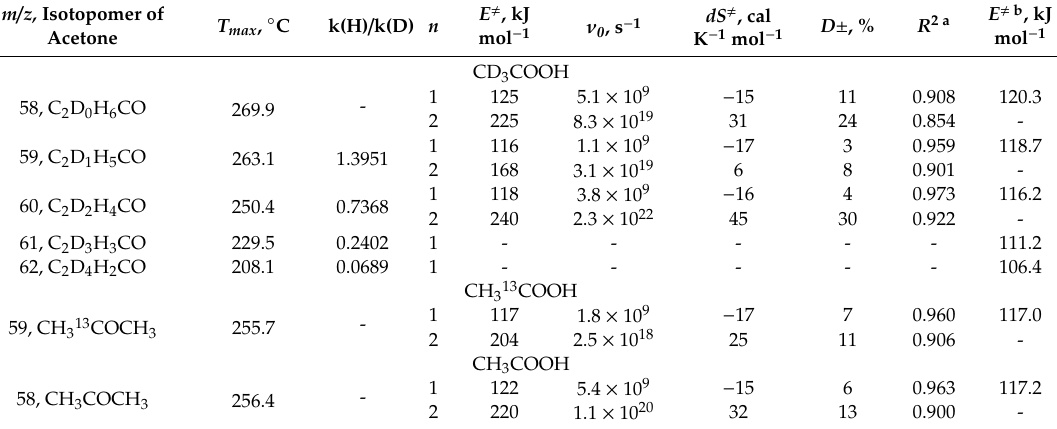
Table 4. Kinetic parameters (temperature of the maximum desorption rate T max , reaction order n , activation energy E (cid:44) , pre-exponential factor ν 0 and activation entropy dS (cid:44) ) of ketonization of CD 3 COOH, CH 313 COOH and CH 3 COOH on the hCeSi surface; the deuterium kinetic isotope e ff ect (k(H) / k(D) obtained using the suggested Equation (5). m / z, Isotopomer of